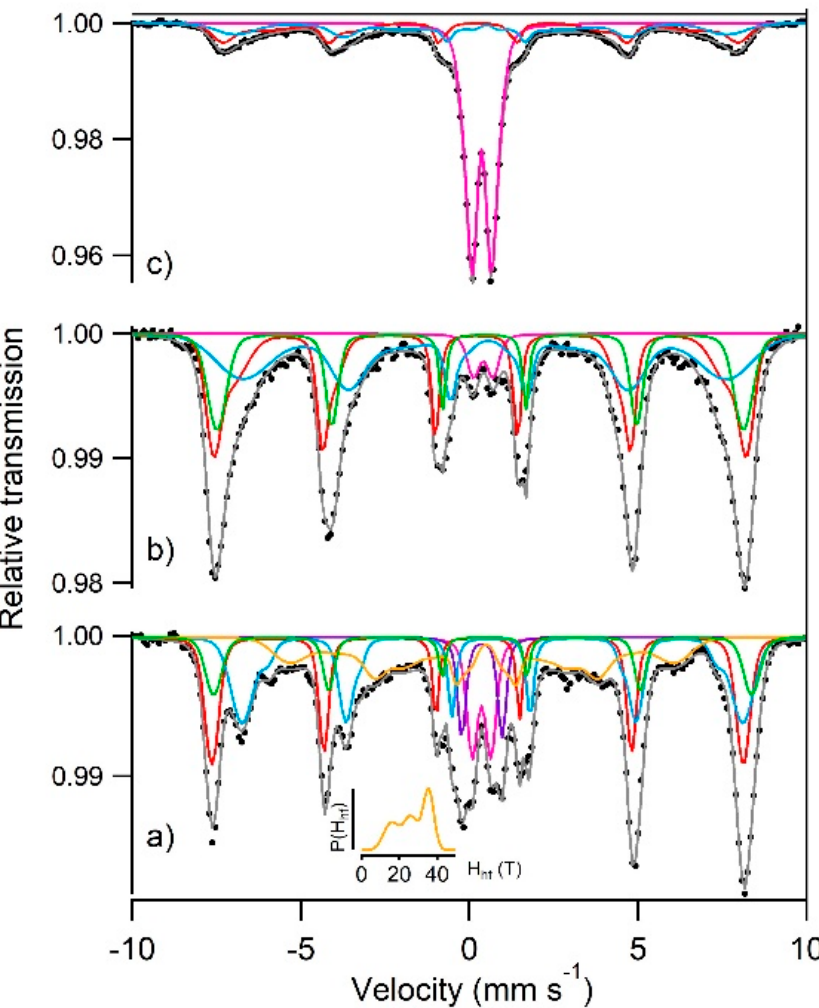
Figure 5. 57 Fe Mössbauer spectra of ( a ) R06F, ( b ) R06B02F, ( c ) R06B05F recorded at room temperature. The inset in (a) gives the probability density distribution of the sextet S4.